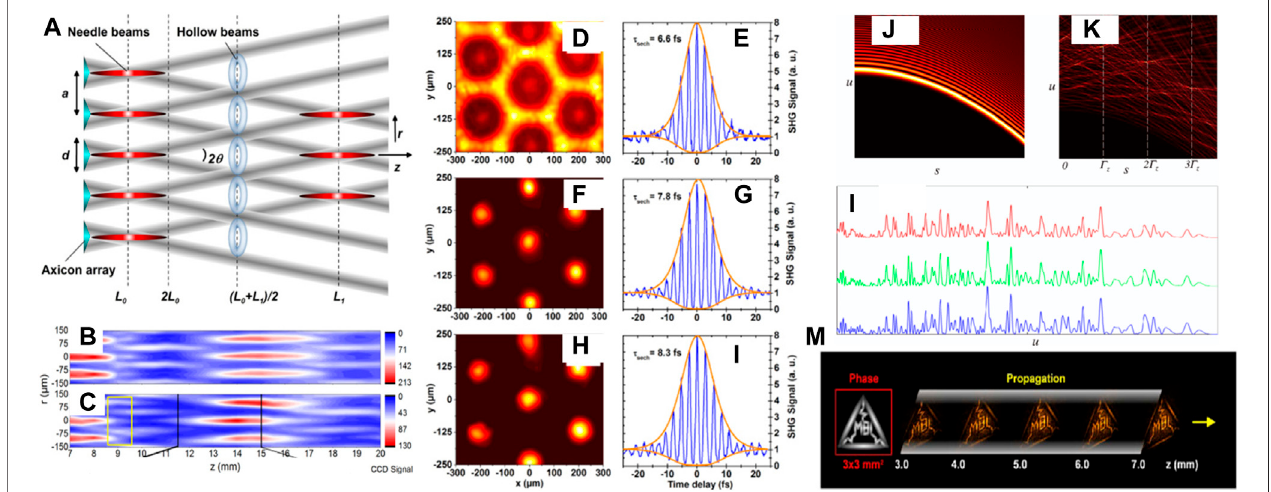
FIGURE10|(A) Schematicsforthenon-diffractiveTalboteffect[114]. (B) Theintensitypropagationofsub-three-cycleneedlebeamsatthefundamentaloscillation wavelengths (B) without and (C) with a local phase distortion (left box, area of distortion) [114]. (D – I) Temporal and spatial evolution of a few-cycle needle beam with a hexagonal con fi guration. (D,E) The axial distance of dark rings ( L 0 + L 1 )/2 (cid:2) 60 μ m, at (F,G) the fi rst and (H,I) second non-diffractive Talbot distance [114]. (J – L) Airy- Talbot effect. The intensity plot of (J) 1D Airy beam and (K) sum of 20 Airy beams. (L) Linear intensity pro fi les at three planes of self-imaging, z (cid:2) Γ , 2 Γ , and 3 Γ , indicated by dashed lines in (K) [116]. (M) Quasi-undistorted evolution of a small-scale temporally ultrashort pattern composed of linear HLWs as fundamental beams [115]. Reproduced with permission from OSA [114, 115] and APS